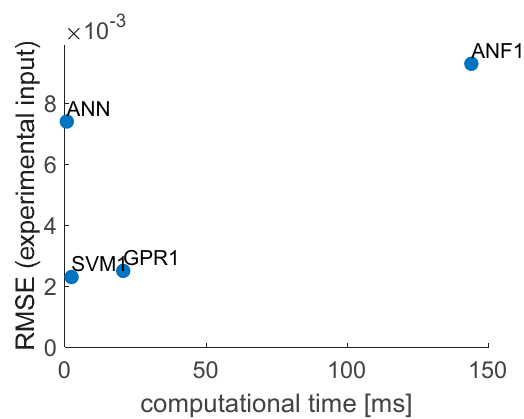
Figure 14. Graphical comparison of accuracy and computational time for chosen models. Table 6. Resultant p -values of comparing different models with t -test (numerical input).